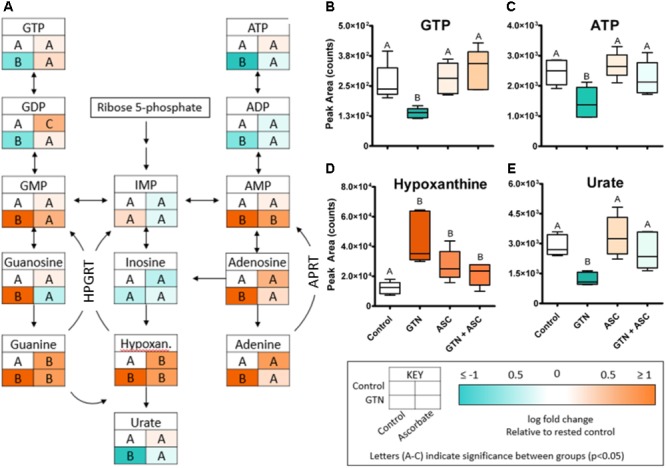
GTN disrupts purine metabolism. (A) GTN treatment resulted in increases of the levels the purines GMP, guanosine, guanine, AMP, adenosine, and adenine; GTN treatment resulted in decreases of nucleotide diphosphates and triphosphates. (B) GTP and (C) ATP are decreased with GTN treatment, which was prevented by ascorbic acid. (D) Hypoxanthine was significantly increased with GTN treatment. (E) Uric acid was significantly decreased with GTN treatment, which was prevented with ascorbic acid co-treatment. One-way ANOVA with Fisher’s post hoc analysis and FDR correction, p < 0.05 indicating significance (n = 6/group), GraphPad Prism 4. P-values for all annotated metabolites are located in Supplementary Table 2. HPGRT, hypoxanthine/guanine phosphoribosyl transferase; APRT, adenine phosphoribosyl transferase.